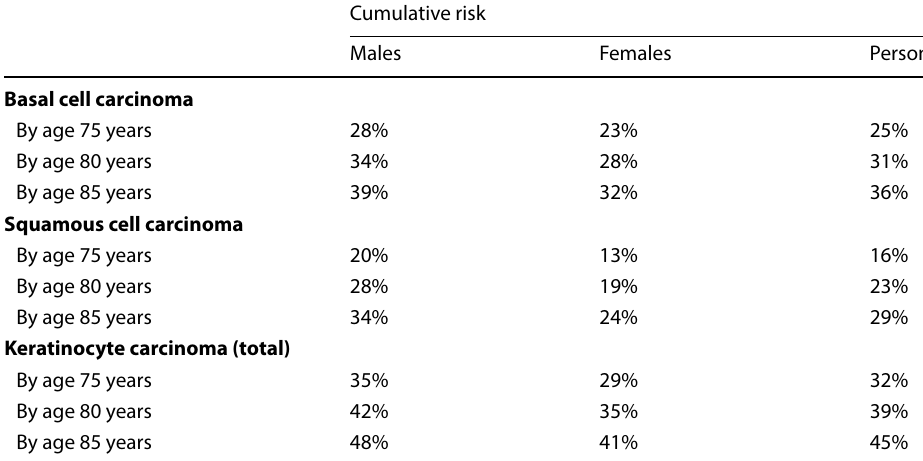
Table 3 Cumulative risk of being diagnosed with a histologically confirmed keratinocyte carcinoma by ages 75, 80 and 85 years in 2018, by histological type and